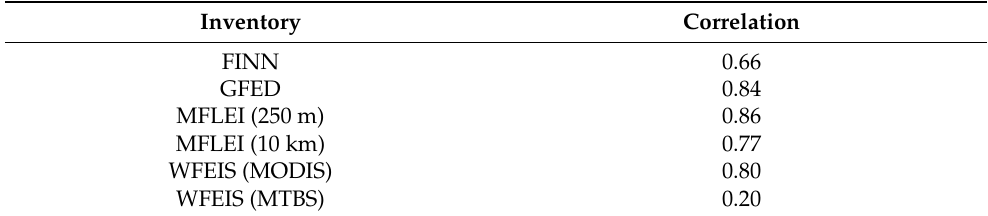
Table 2. Pearson correlation coefficients between daily, summed VIIRS FRP and daily, summed PM 2.5 for each emissions inventory. The correlation between VIIRS FRP, an external dataset, and daily PM 2.5 for each inventory assesses the trends captured by each emissions inventory compared to VIIRS FRP data. All correlation coefficients are statistically significant ( p ≤